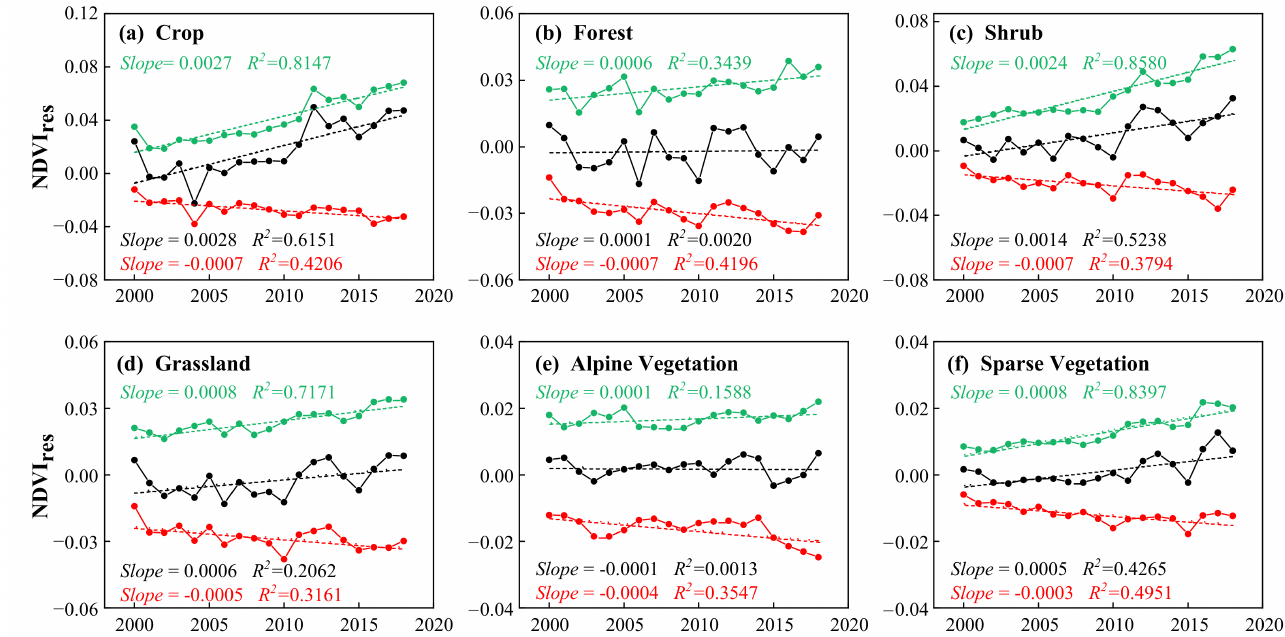
Figure 7. The interannual changes of NDVI res for different types of vegetation from 2000 to 2018. ( a ) crop; ( b ) forest; ( c ) shrub; ( d ) grassland; ( e ) alpine vegetation; ( f ) sparse vegetation. The black line: the average value of NDVI res ; the green line: the positive value of NDVI res ; the red line: the negative value of NDVI res